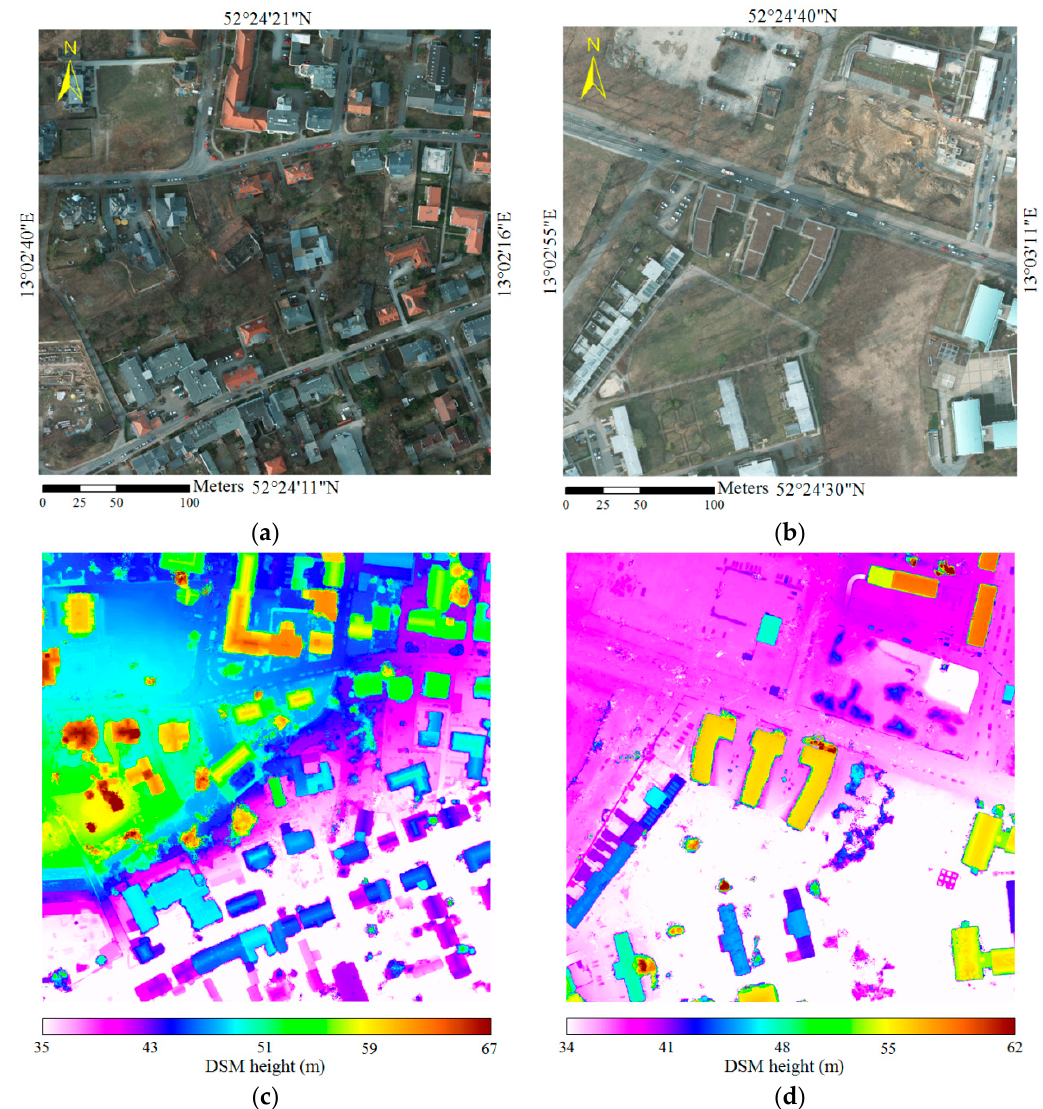
Figure 11. ISPRS true orthophoto tiles for the test regions ( a ) and ( b ) and the corresponding DSMs ( c ) and ( d ).